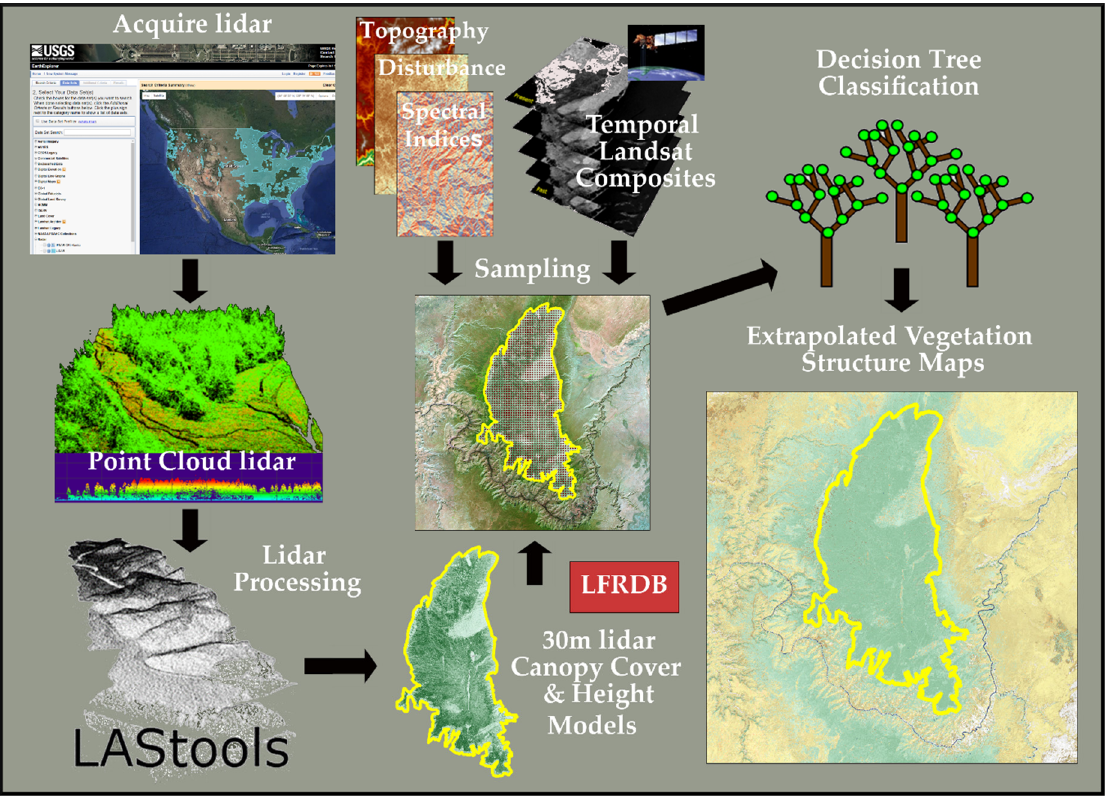
Figure 5. Remap prototyping schema for using lidar data to model continuous vegetation structures including Existing Vegetation Height (EVH) and Cover (EVC) [36] (reproduced with permission) .